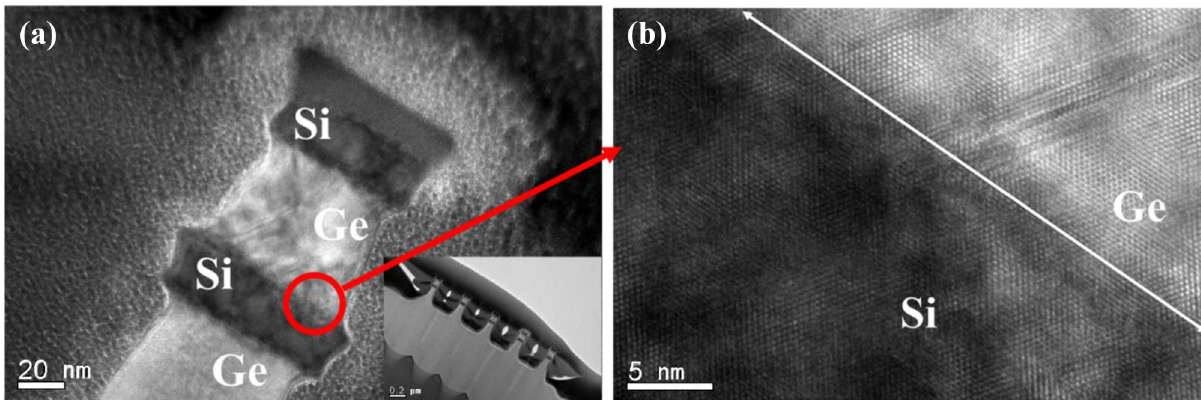
Figure 3. ( a ) TEM images showing misfit dislocations along the Ge/Si interface and the resulting threading dislocations across the Ge film; ( b ) enlarged micrographs with misfit dislocations at the Ge/Si interface showing the formation of a relaxed single-crystalline Ge(100) layer on the wafers.